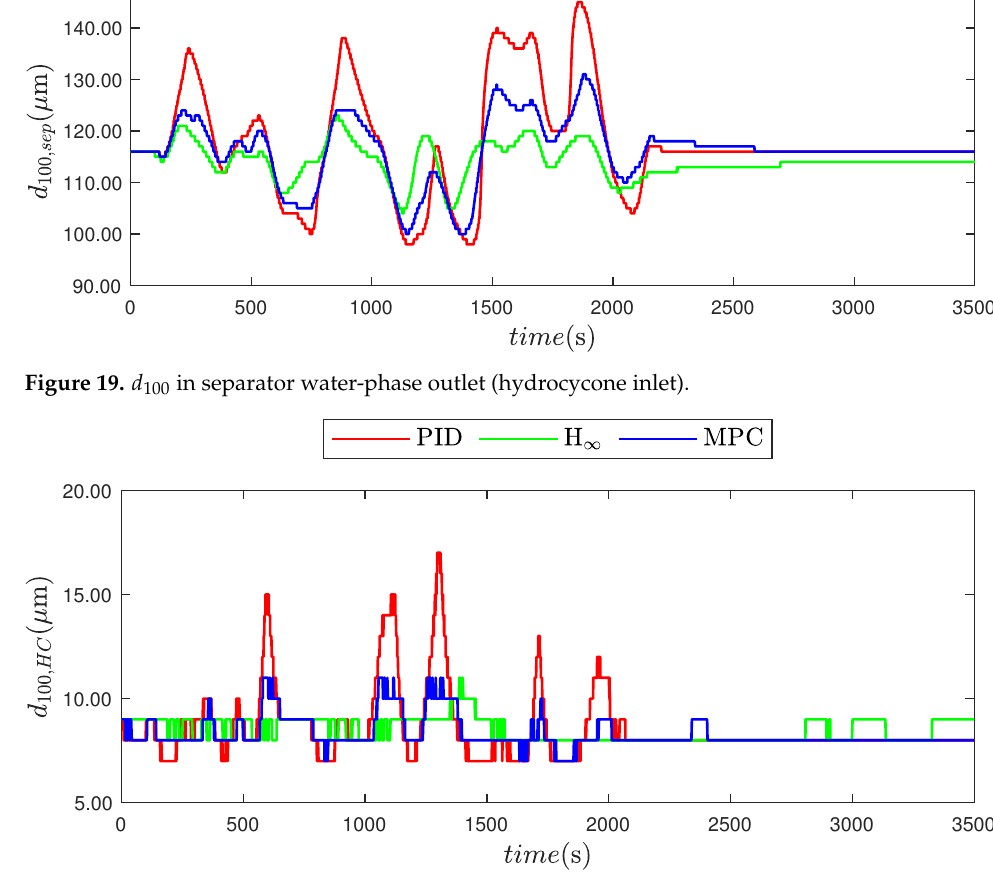
Figure 20. d 100 in hydrocyclone